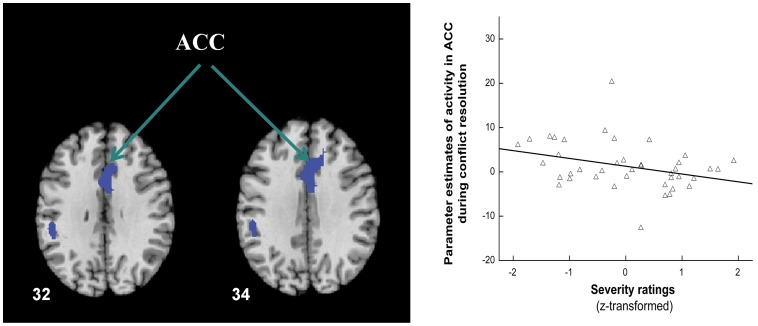
Severity correlation.Axial–oblique views of brain regions in stutterers show negative correlations between the magnitude of brain activation during conflict resolution and stuttering severity as measured with the ACES and OASES. The scatter plot illustrates the negative association in the ACC between the standardized severity score and the parameter estimate of brain responses during conflict resolution (r = −0.33, p<0.025). Abbreviations: ACC = anterior cingulate cortex.